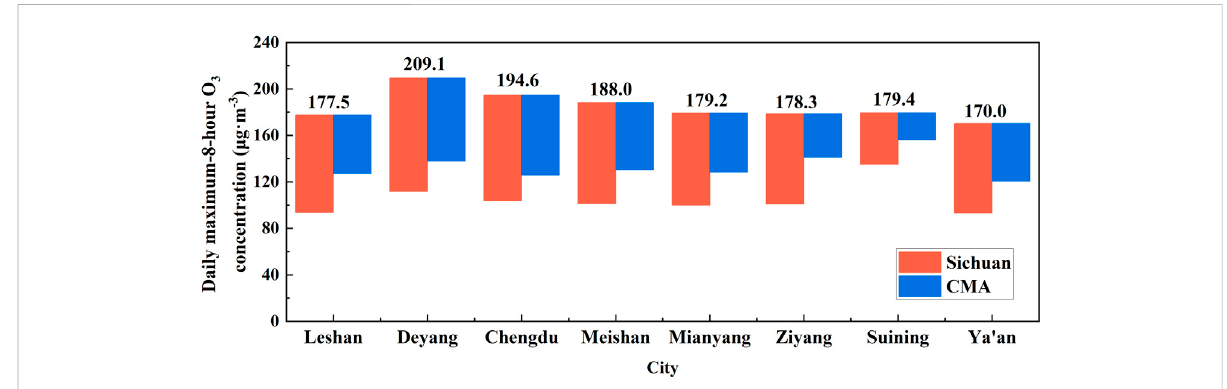
FIGURE 7 Theeffectsof100%NO x andVOCsemissionreductionsonMDA8O 3 concentrationsineightcitiesfortheCMAandSichuanProvincescenarios.